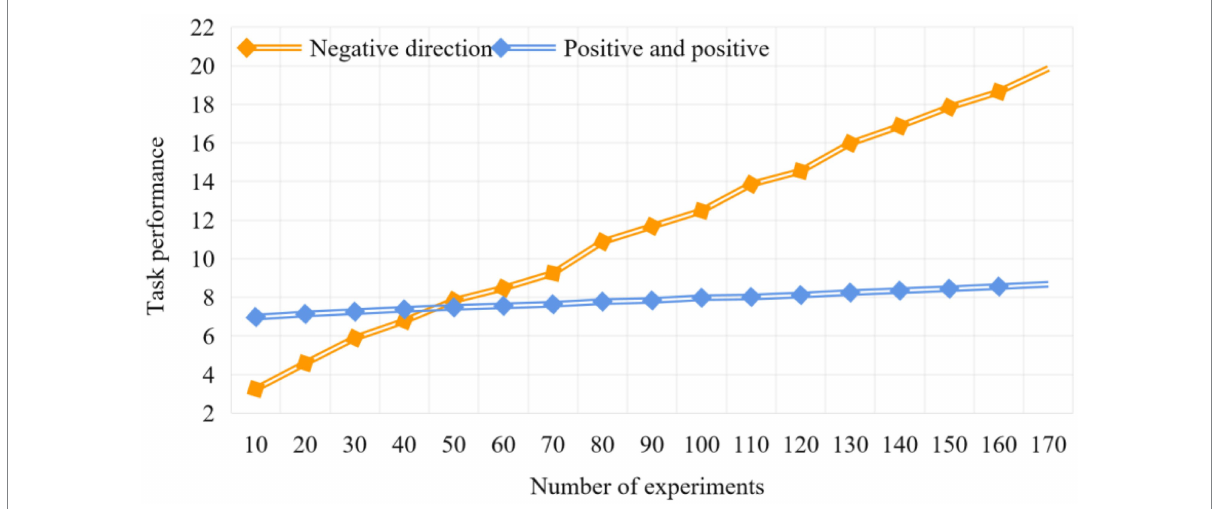
FIGURE 3 Adjustment of employee and team task performance in enterprises with heterogeneous attitudes.